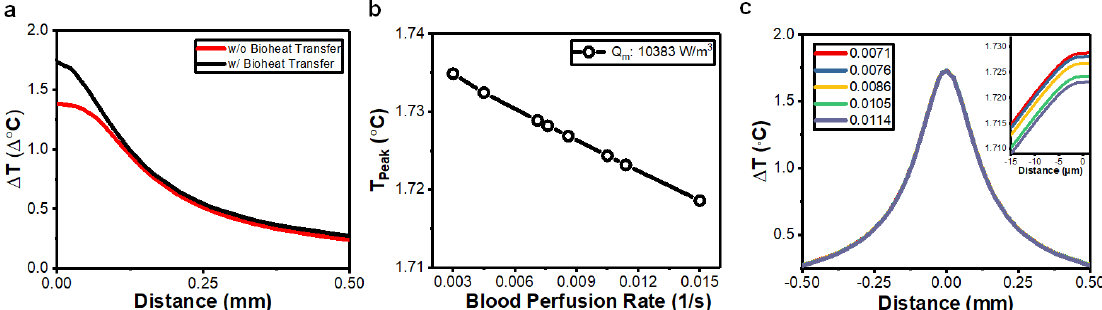
Figure 7. Temperature changes with various blood perfusion rates. ( a ) Thermal impacts of the metabolic heat generation and blood perfusion rate. ( b ) Temperature changes by the TP optical fiber with a change in the blood perfusion and metabolic heat generation of 10,383 W/m 3 . ( c ) Temperature distribution by photothermal stimulation in the x -axis from the fiber tip under a various blood perfusion rates. Heat rate (equivalent laser power) and penetration depth were set to 1 mW (Equivalent light power: 15.8 mW) and 1.4 mm, respectively.